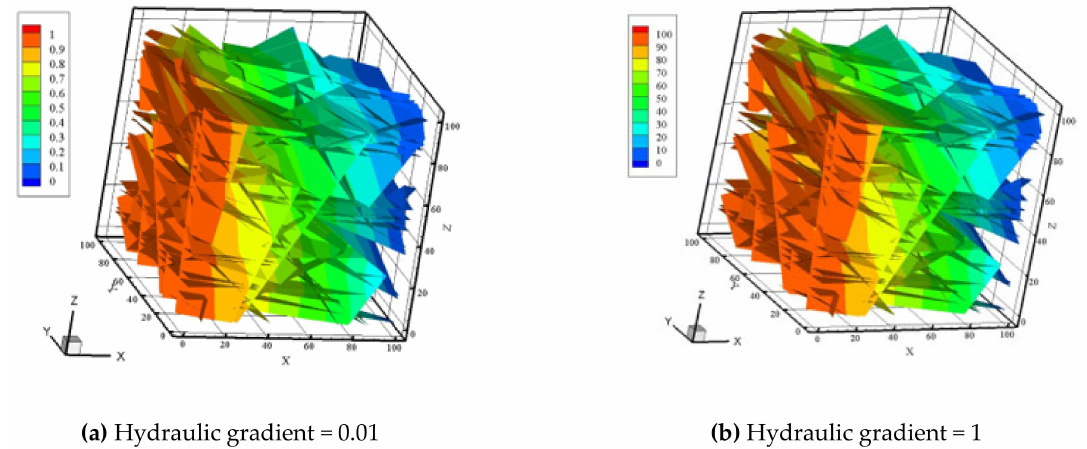
Figure 13. Pressure contour of 3D DFN calculated by the proposed method (unit: Pa)